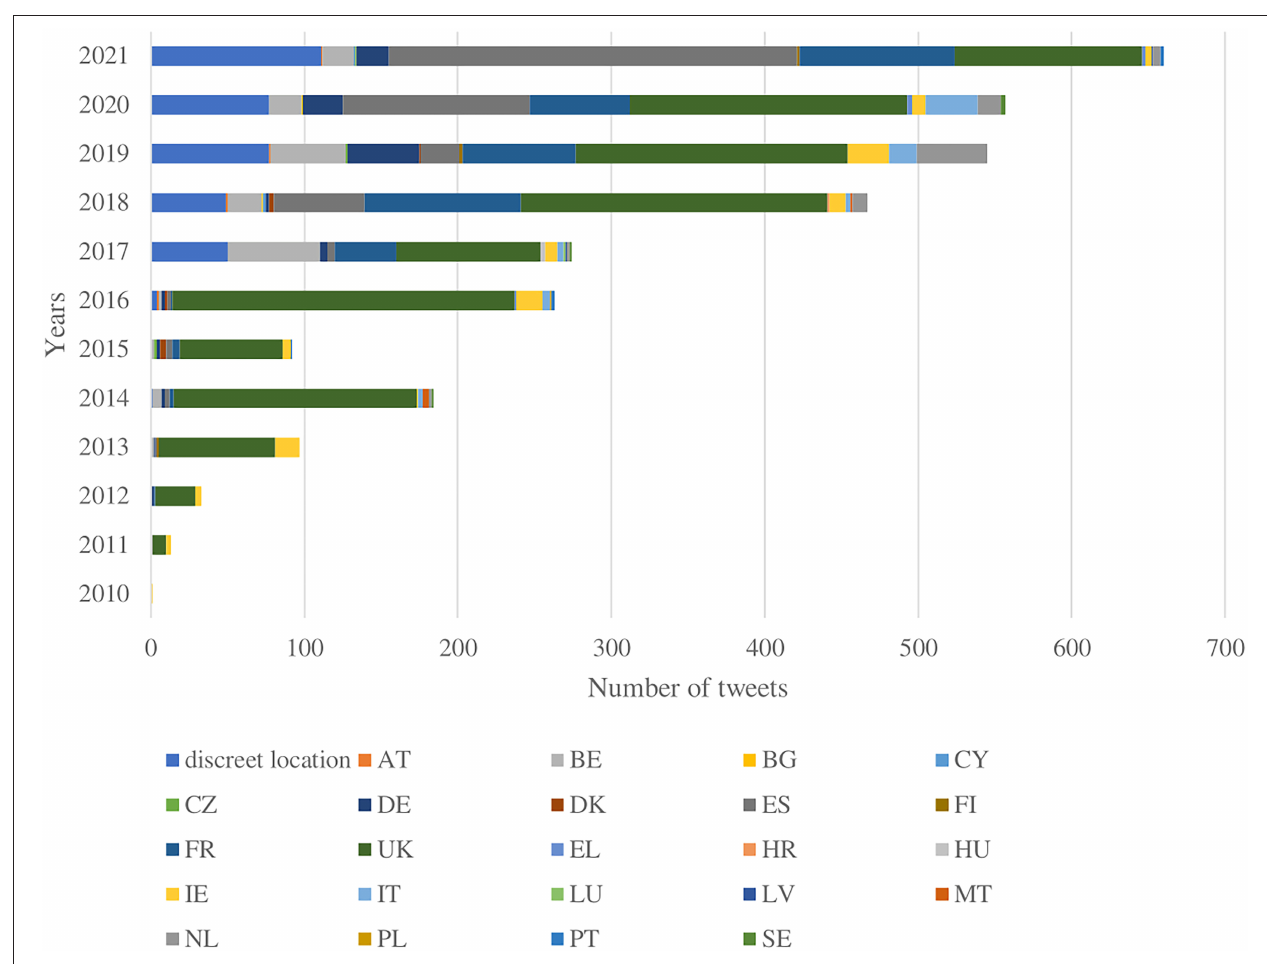
FIGURE 1 | Tweets per country over time. The graph shows the number of tweets per year stacked for each country. Two-letter country codes: Austria (AT), Belgium (BE), Bulgaria (BG), Cyprus (CY), the Czech Republic (CZ), Germany (DE), Denmark (DK), Greece (EL), Spain (ES), Finland (FI), France (FR), Croatia (HR), Hungary (HU), Ireland (IE), Italy (IT), Latvia (LV), Luxembourg (LU), Malta (MT), The Netherlands (NL), Poland (PL), Portugal (PT), Sweden (SE), and the United Kingdom